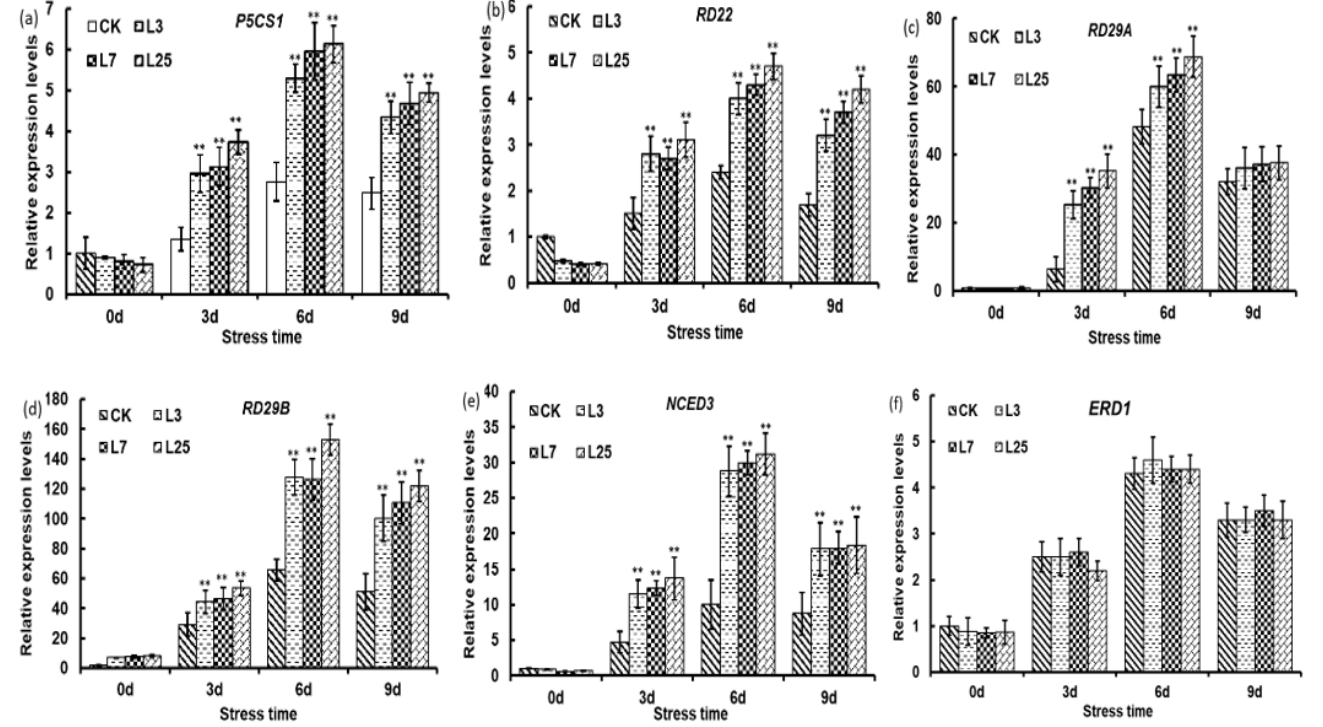
Figure 7. Relative expression levels of six stress response genes ( P5CS1 , RD22 , RD29B , RAB18 , NCED3 and ERD1 ) in Arabidopsis lines (L3, L7 and L25) at 0, 3, 6 and 9 days after drought stress. ** indicate a significant difference at the 1% level. ( a ) Relative expression levels of P5CS1 in Arabidopsis lines (L3, L7 and L25) at 0, 3, 6 and 9 days after drought stress. ( b ) Relative expression levels of RD22 in Arabidopsis lines (L3, L7 and L25) at 0, 3, 6 and 9 days after drought stress. ( c ) Relative expression levels of RD29A in Arabidopsis lines (L3, L7 and L25) at 0, 3, 6 and 9 days after drought stress. ( d ) Relative expression levels of RD29B in Arabidopsis lines (L3, L7 and L25) at 0, 3, 6 and 9 days after drought stress. ( e ) Relative expression levels of NCED3 in Arabidopsis lines (L3, L7 and L25) at 0, 3, 6 and 9 days after drought stress. ( f ) Relative expression levels of ERD1 in Arabidopsis lines (L3, L7 and L25) at 0, 3, 6 and 9 days after drought stress.